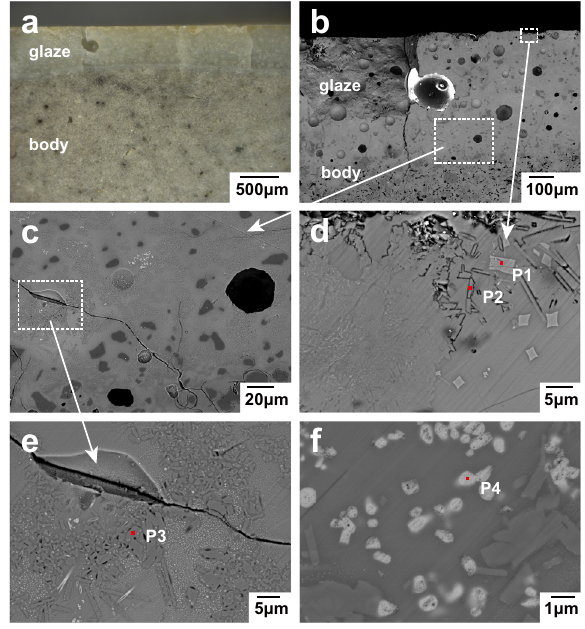
Fig. 9 OM and SEM images of sample No. 08. a and b are the OM and SEM images of the polished cross section, respectively; c and d are the magni fi ed SEM images of the glaze-body interface and the area close to the glaze surface, respectively; e SEM image of the rectangle region in c : short column-like anorthite crystals and phase- separation structure; f SEM image of the rectangle region in d : crystals with elliptical cross